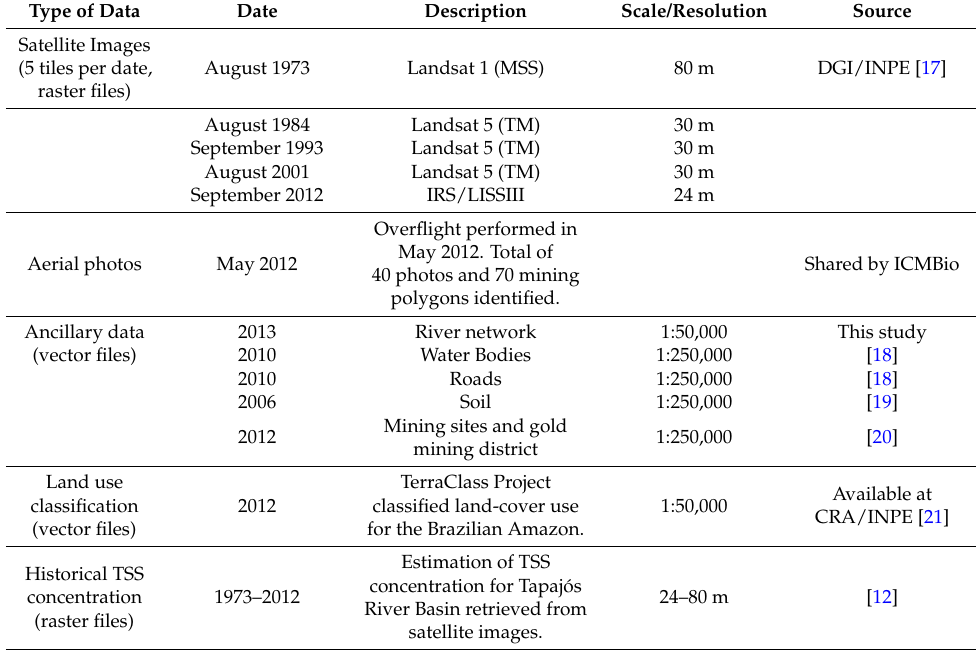
Table 1. Description of the geographical database used including type of data, date of acquisition, general description, scale and source of